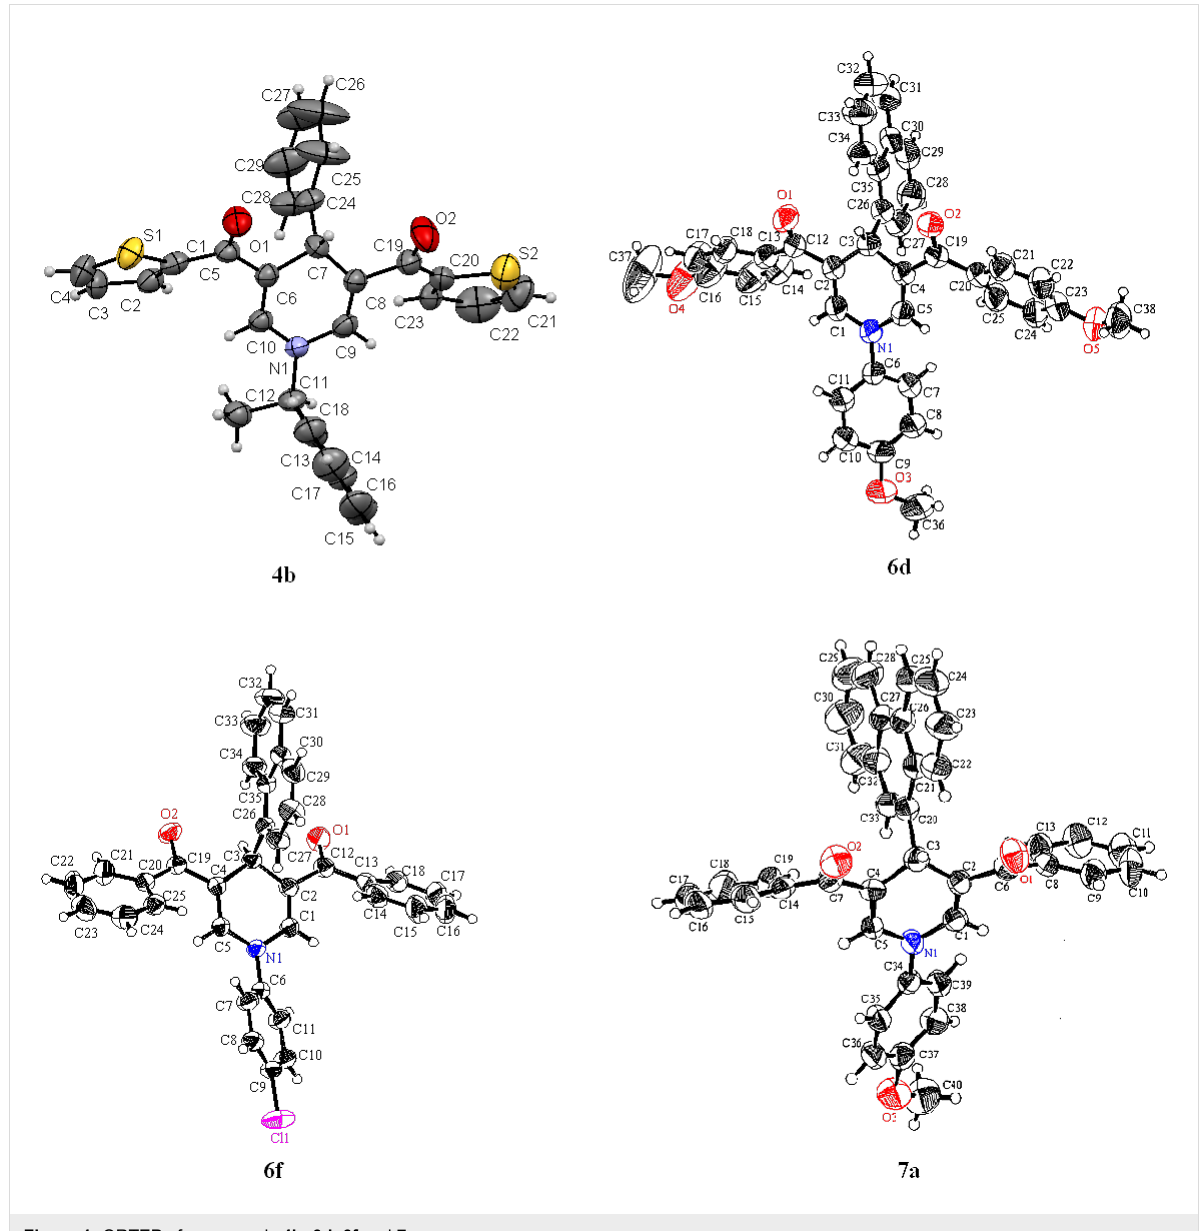
389–406 nm. The shorter absorption wavelength is attributable to the aryl groups and the longer absorption is due to the DHP moiety [8]. Upon excitation at each of these two λ max these compounds gave fluorescence spectra (Figure 3 and Figure 4) with λ max = 454–492 nm (Table 2). This photoluminescence behavior of 6 and 7 resembles that of dihydropyridinedicar- boxylate derivatives [7,8], which suggests their potential appli- cation as suitable photoinduced intramolecular electron-transfer systems. For comparison the absorption and emission spectra of 2j and 4a have also been measured, and the results indicate weak emissions relative to 7b . This compound, with the